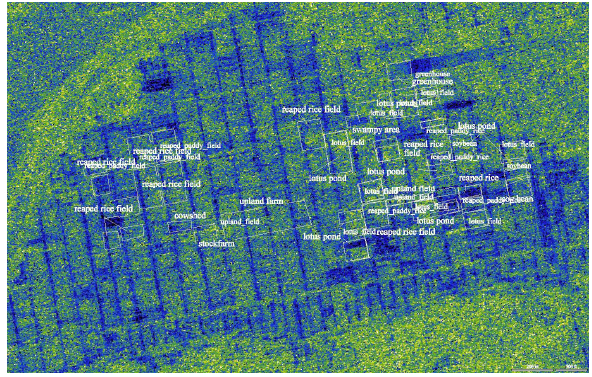
Figure 11. the RVI result of the south side of the Tone